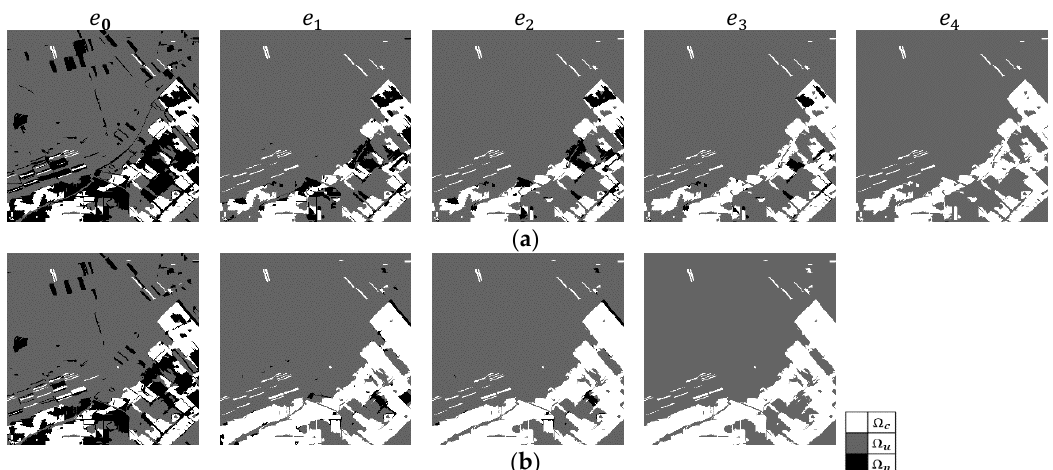
Figure 13. The CD results of the proposed methods for each epoch. The uncertainty level increased at Site 1: ( a ) from Level 1 to Level 3; and ( b ) from Level 2 to Level 3. Grey ( Ω c ) , white ( Ω u ) , and black ( Ω n ) colors represent the change, no-change, and no-value classes, respectively.